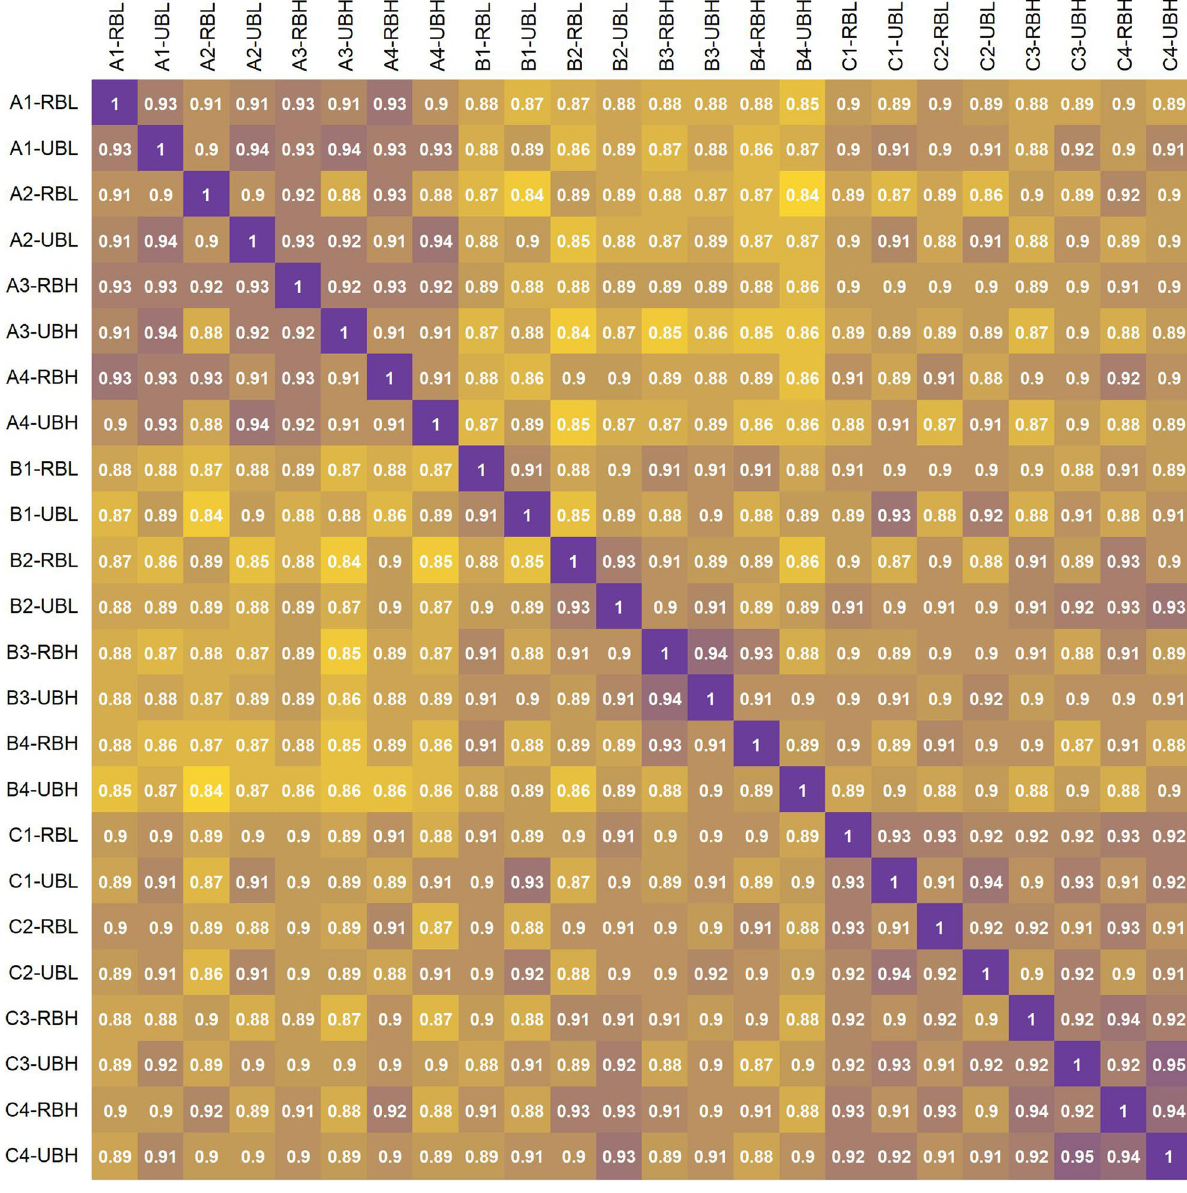
Figure 3. Pearson correlation between all 24 samples using regularized logarithm transformed RNA-seq data plotted using R version 4.0.0 (r-project.org). Mesocarp samples are categorised into early (up to 17/18 WAA) and late (after 17/18 WAA) developmental stages denoted by the plot’s row/column labels containing -U and -R, respectively. Samples labelled as A1–4; B1–4 and C1–4 were from OxG, BC2 (2.6–1) and BC2 (2.6–5) populations, respectively. For C16:0 content, “low” (-U/RBL) ranged from 22.2–28.9% while “high” (-U/RBH) ranged from 33.1–40.6% with respect to the level of C16:0 in